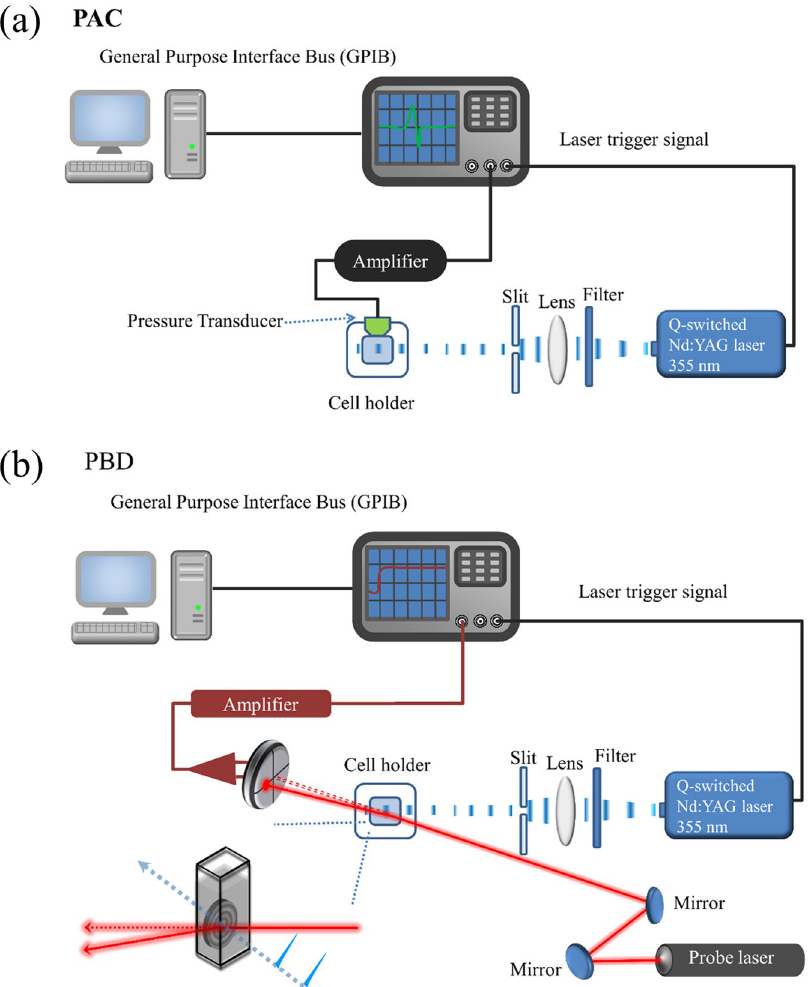
Figure 2. The schematic diagrams of two photothermal methods. ( a ) photoacoustic calorimetry; ( b ) photothermal beam